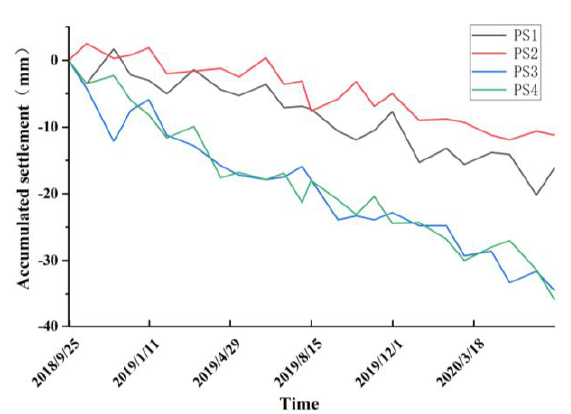
Figure 8. Time series accumulated subsidence in each